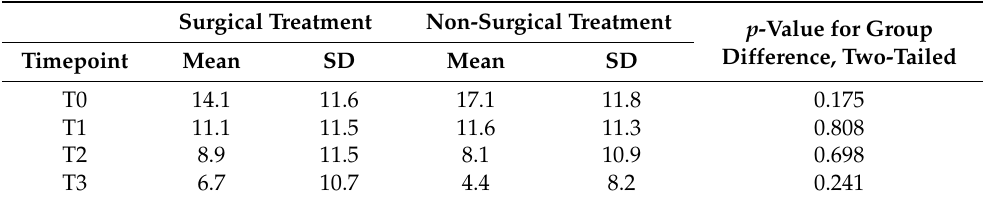
Table 2. Descriptive statistics OHIP 14 index scores ( p < 0.05. Equality of variance assumed, two-tailed t -test).